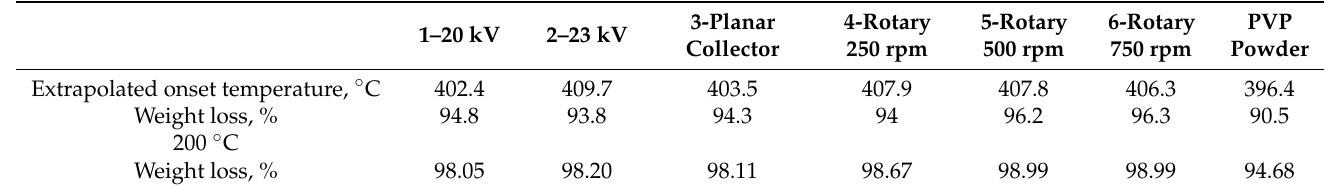
Table 3. DSC results.